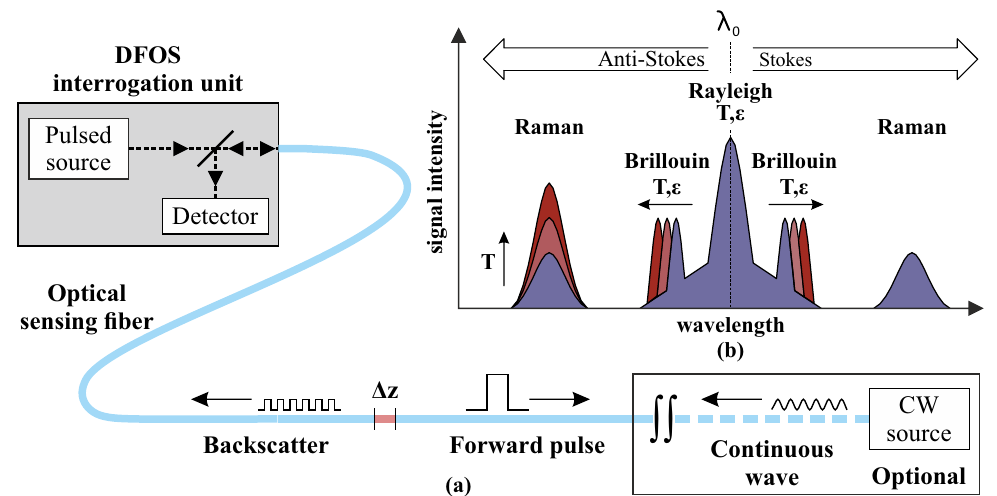
Figure 1. Distributed fiber optic sensing techniques [30]: ( a ) Basic scheme of sensing setup. ( b ) Dif- ferent scattering components in optical glass fibers.